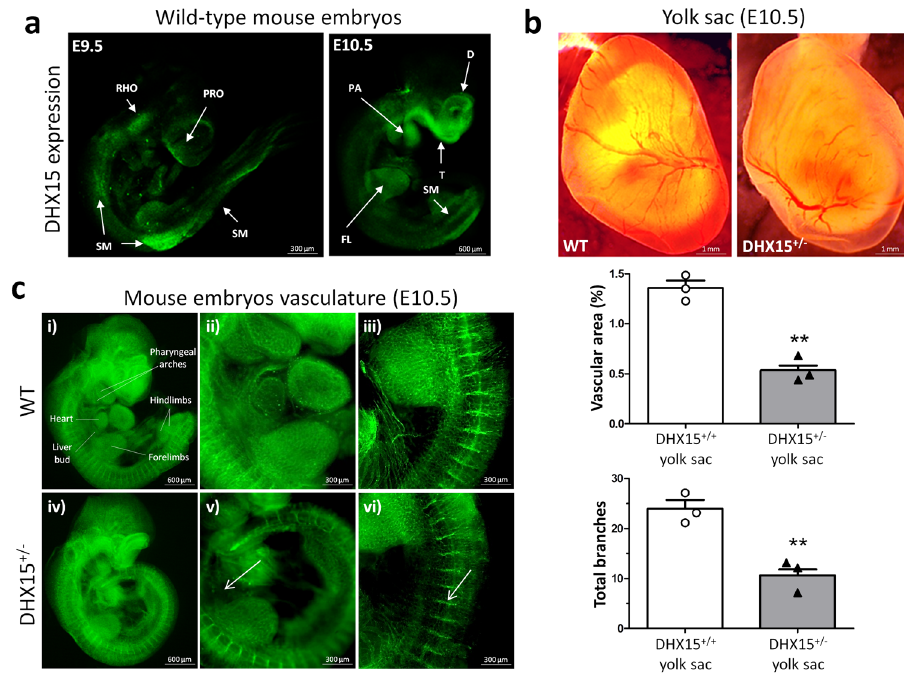
Fig. 2 Embryonic characterization of DHX15 gene de fi ciency and expression in the gene-edited mouse and zebra fi sh models. a Representative immunostaining of the DHX15 expression (green) from mouse embryos at E9.5 and E10.5 of embryonic development ( n = 3 animals for each embryonic day). Maximal projection is shown. Original magni fi cation: ×20 for E9.5 and ×10 for E10.5. b Representative bright- fi eld images of the yolk sac vasculature from mouse embryos at E10.5 of embryonic development. Maximal projection is shown for each genotype. Original magni fi cation: ×8. The vascular density quanti fi cation is shown on the histograms expressed as the percentage of vascular area (upper graph) and total branches (lower graph). Bars represent the mean ± SEM, ** p < 0.01 vs. wild-type, unpaired two-tailed Student ’ s t -test ( n = 3 animals for each condition). c Representative immunostaining of the vasculature with endomucin (green) from mouse embryos at the stage E10.5 of embryonic development. The white arrows denote areas of decreased vascular density ( n = 6 animals for each condition). Maximal projection and 3D rendering from the microscope are shown for each genotype. Original magni fi cation: ×20 and